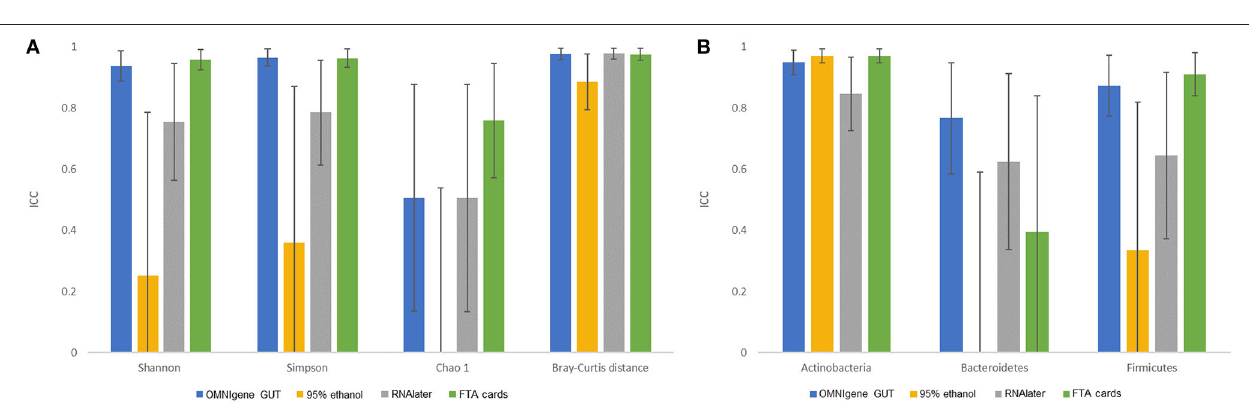
FIGURE 2 | The concordance of microbiota obtained by different fecal collection methods compared with the gold standard immediate freezing: intraclass correlation coefficients (ICC) and 95% CI for: (A) three α - diversity metrics and β - diversity Bray-Curtis distance. (B) top three phyla.